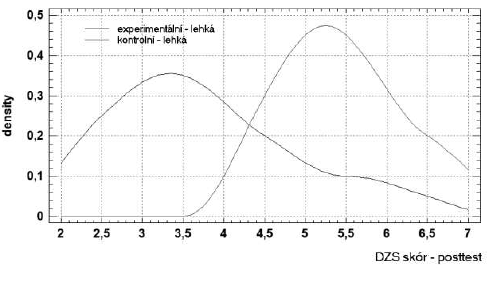
Figure 3. Arithmetic